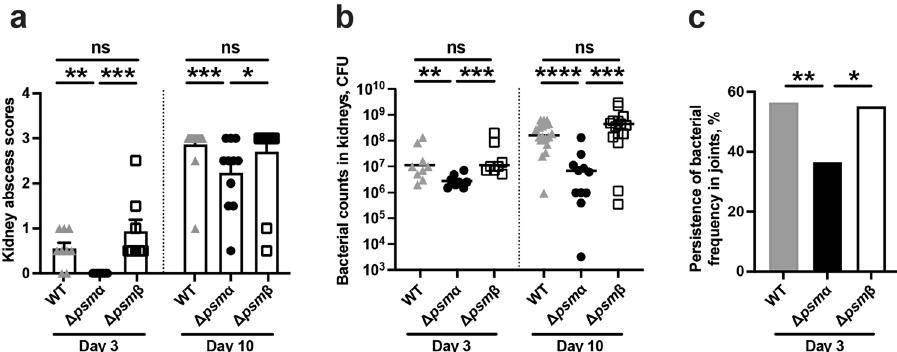
Fig. 6 Bacterial clearance in kidneys and joints is attenuated by PSM α . NMRI mice ( n = 8 – 21/group) were intravenously injected with S. aureus Newman (wild type, WT), or the isogenic mutant strains Δ psm α or Δ psm β (5 × 10 6 CFU/mouse) and sacri fi ced on day 3 or day 10 post-infection. a Kidney abscess scores and b persistence of S. aureus in kidneys 3 days and 10 days after infection. The results from four independent experiments were pooled. c Persistence of S. aureus frequency in joints including shoulders, elbows, front paws, hips, knees, and hind paws of the mice 3 days after infection. Statistical evaluations were performed using the Mann-Whitney U test a , b , or Fisher ’ s exact test c . Data are presented as the mean ± standard error of the mean a or median b . * P < 0.05; ** P < 0.01; *** P < 0.001; **** P < 0.0001; ns not signi fi cant.